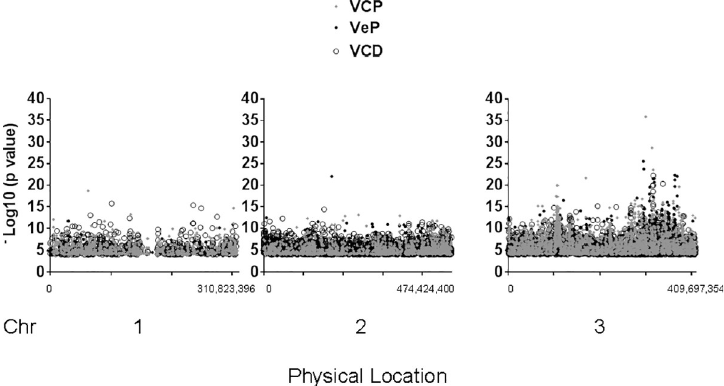
Fig 1. Genes with statistical association to pyrethroid resistance. Genes (FDR, p < 0.01, -log 10 (p value) of χ 2 contingency calculation � 4.0) in each of three collections, Viva Caucel permethrin (VCP, gray circle), Viva Caucel deltamethrin (VCD, open circle), and Vergel permethrin (VeP, black circle) were plotted according to the average physical position of each gene (AaegL5 genome build). X-axis shows beginning and end locations of polymorphisms on each chromosome.